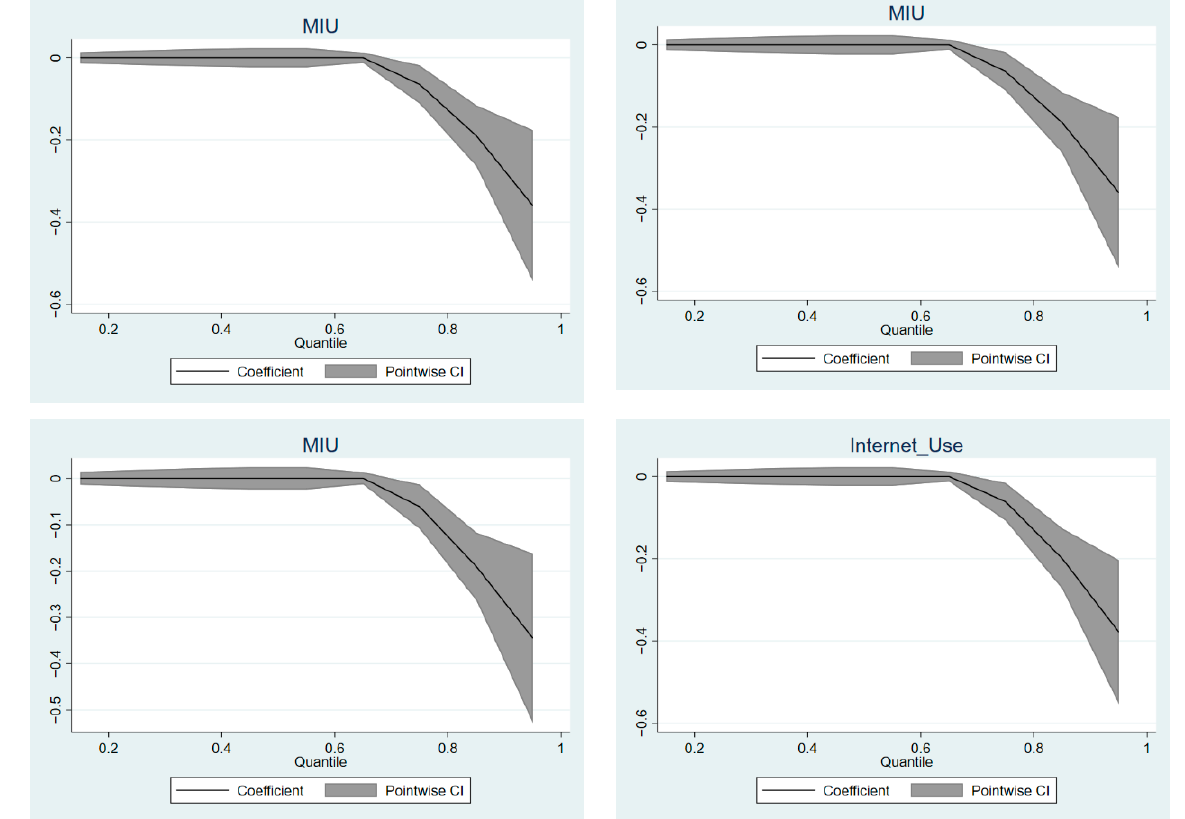
Figure 3. Quantile regression coefficient plots of sensitivity analysis.